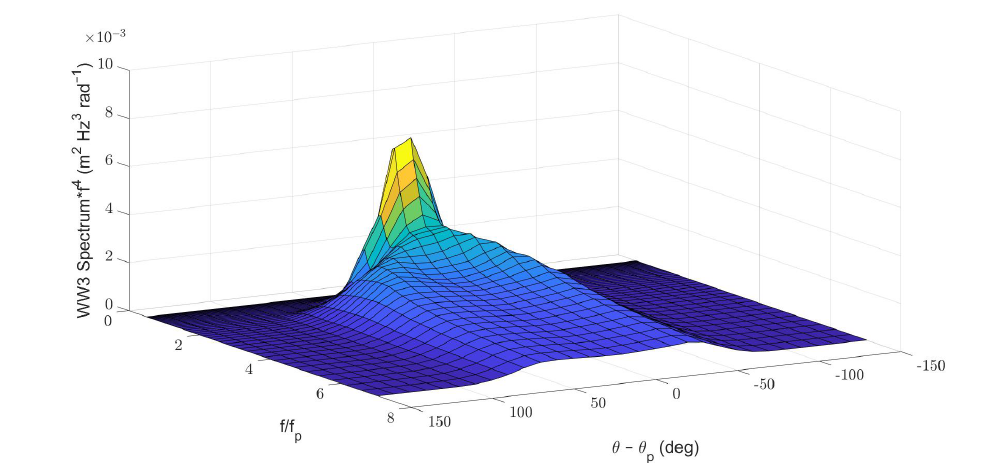
Figure 1. Three-dimensional wave spectrum from the WW3/DIA-40 hindcast for the Draupner storm on 1 January 1995 at 15:00, at Station 1, 58.17 ◦ (58 ◦ 10 (cid:48) 12 (cid:48)(cid:48) )N 2.47 ◦ (2 ◦ 28 (cid:48) 12 (cid:48)(cid:48) )E. The spectrum has been transformed to a compensated form via multiplication by f 4 , where f is the frequency. Frequencies have been made dimensionless by dividing them by the frequency f p at the peak of the spectrum. The plot is centered around the peak direction θ p